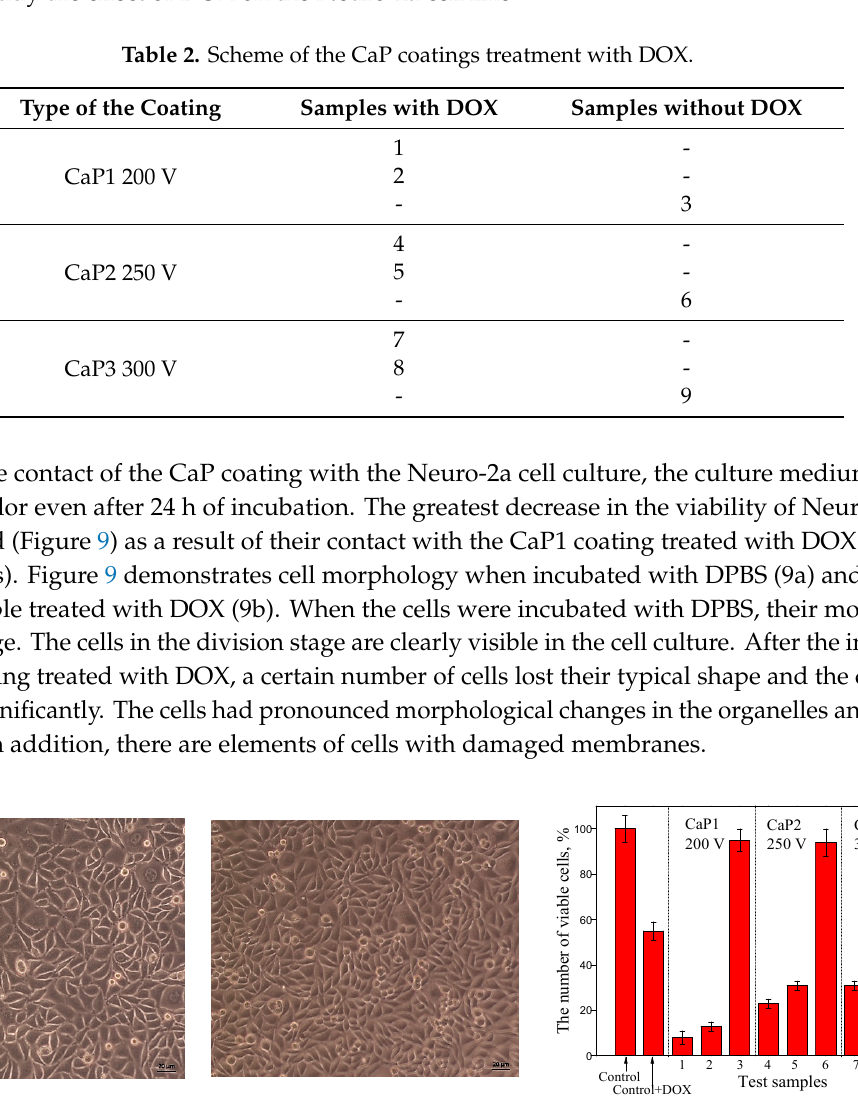
Table 2. Scheme of the CaP coatings treatment with DOX.